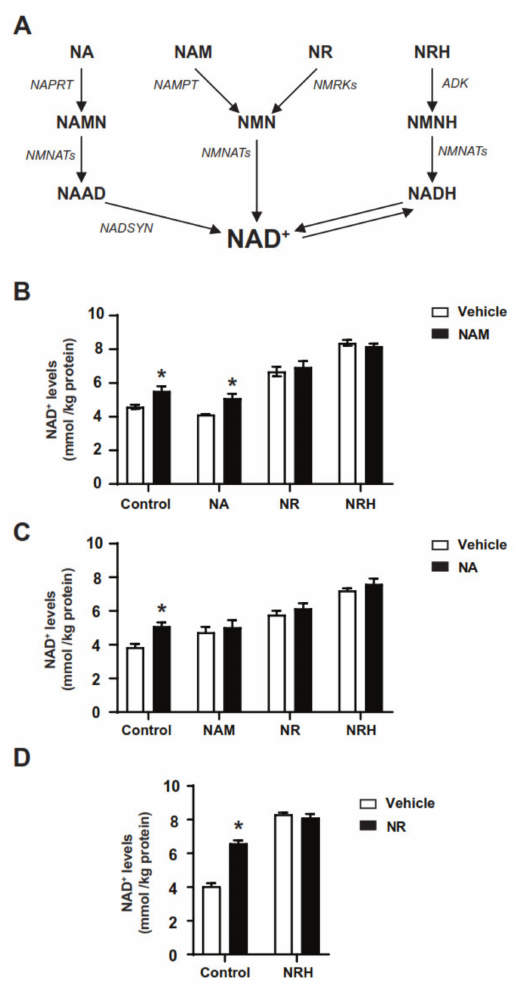
Figure 1. The different routes for NAD + synthesis and their combinatorial effects. ( A ) Scheme depicting the five main NAD + synthesis routes in mammals. NA: nicotinic acid; NAM: nicotinamide; NR: NAM riboside; NRH: dihydronicotinamide riboside; NAMN: NA mononucleotide; NMN: NAM mononucleotide; NMNH: dihydronicotinamide mononucleotide; NAAD: NA adenine dinucleotide; NAD: nicotinamide adenine dinucleotide in its reduced (NADH) or oxidized (NAD + ) form. NAPRT: NA phosphoribosyltransferase; NAMPT: NAM phosphoribosyltransferase; NMRKs: NR kinases; ADK: adenosine kinase; NMNATs: NMN adenylyltransferases; NADSYN: NAD synthase. ( B )